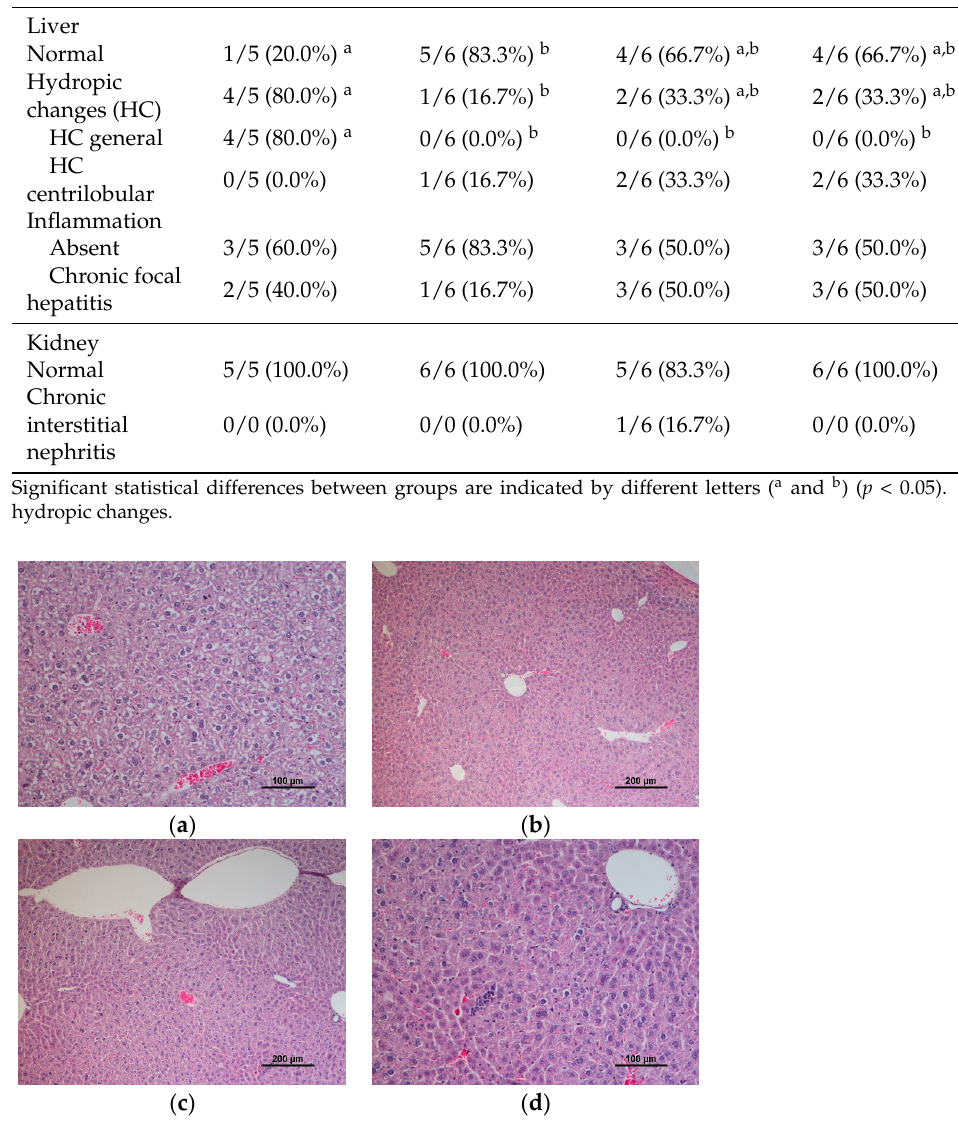
Figure 3. Hematological parameters evaluated (mean ± SE): ( a ) microhematocrit, ( b ) creatinine, ( c ) ASAT (aspartate aminotransferase), ( d ) ALAT (alanine aminotransferase), and ( e ) urea. * Statisti- cally significant differences ( p < 0.05).